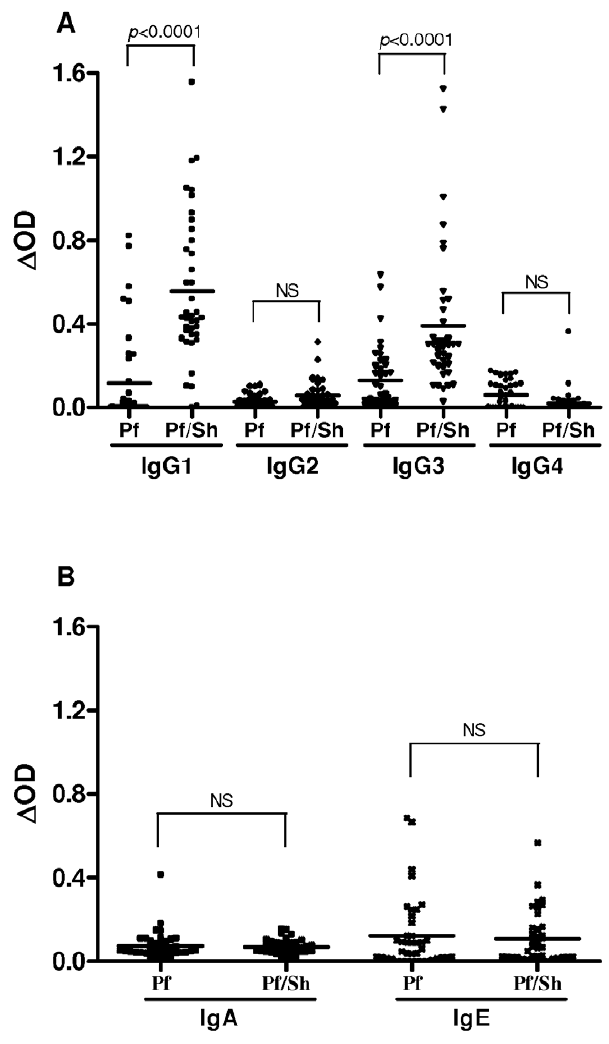
Figure 2. Specific Ab responses to schizont extract in children infected by P. falciparum ( Pf - n=40) and coinfected with S. haematobium ( Pf-Sh - n=39) as determined by ELISA. Results represent individual values of D OD and bars are the arithmetic mean for each group. Statistical significance between each group is indicated. (A) isotypes IgG1, IgG2, IgG3 and IgG4, (B) isotypes IgA and IgE.